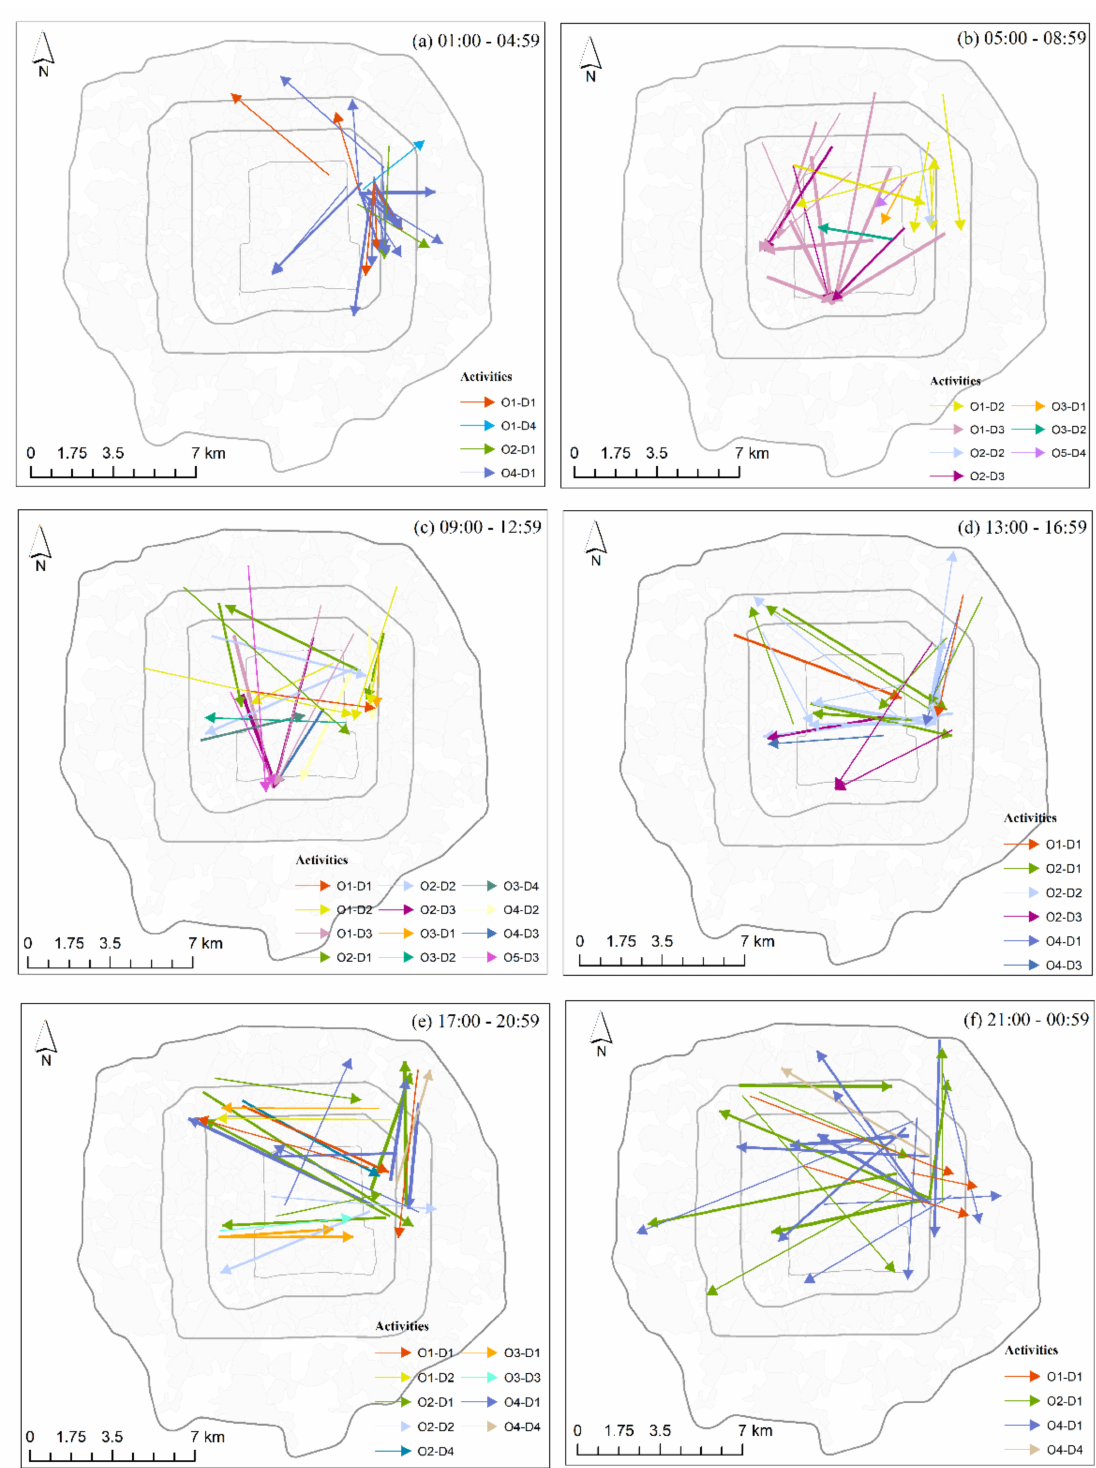
Figure 10. The spatial distribution of significant taxi activity semantic flow clusters at different periods. The flow color represents the activity semantic type, and the flow width is proportional to the number. O1 and D1: Home-related activity; O2 and D2: Work-related activity; O3 and D3: Transportation activity; O4 and D4: Recreation-related activity; O5: Hotel-related activity; O6: Medical-related